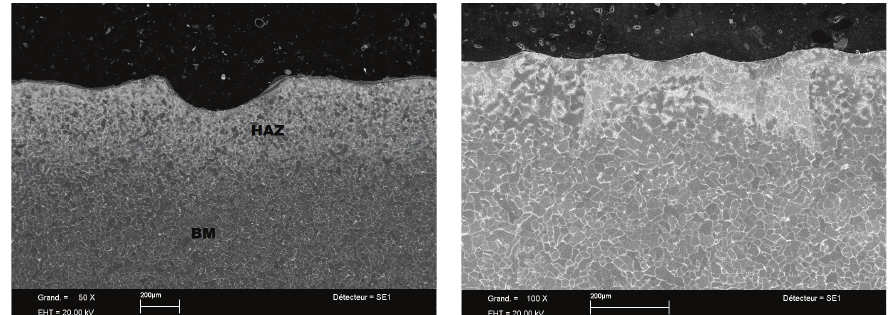
Figure 3: Microstructure of HAZ and base material (BM).